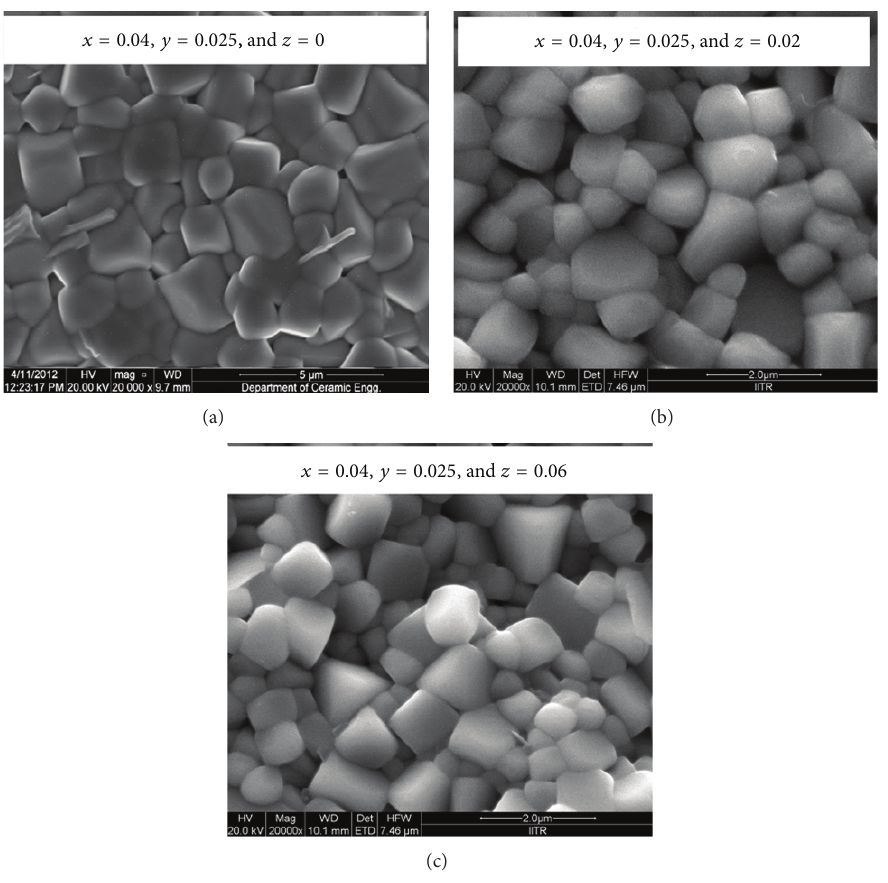
Figure 2: Microphotographs of [ 1 − 𝑧 (BLNLT)- 𝑧 (BT)] system for 𝑧 = 0 , 0.02, and 0.06. Table 1: Electrical properties of [ 1 − 𝑧 BLNLT- 𝑧 BT]